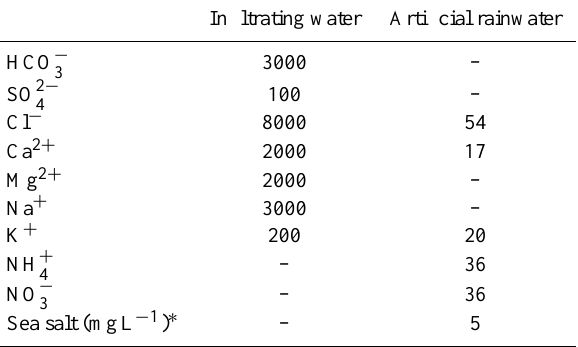
Table 1. Composition of the infiltrating water and artificial rainwa- ter used in the experimental set-up. The rainwater composition was based on the composition of Dutch rainwater. Note that all concen- trations are in µmolL − 1 , except for the sea salt addition, which is in mgL − 1 . Infiltrating water Artificial